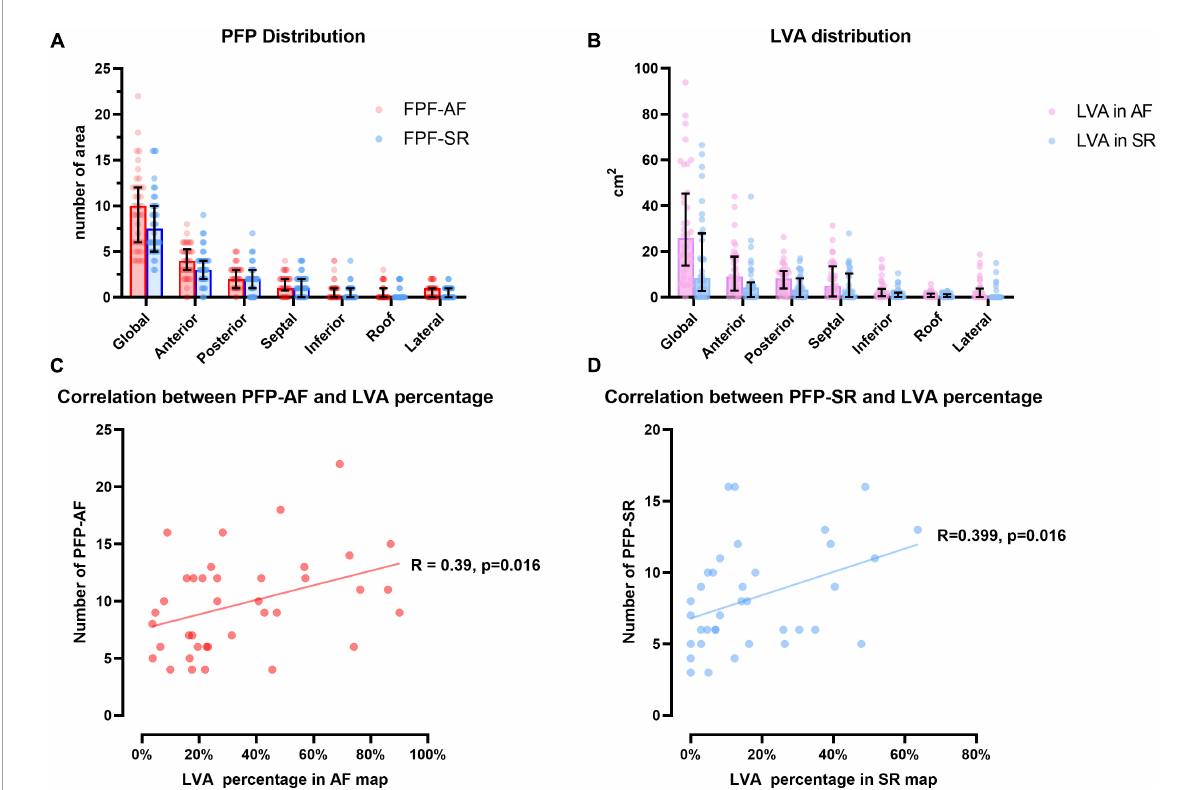
FIGURE3 Distribution of areas presenting prolonged fractionated potential and low voltage area. (A) Illustrates the number of areas presenting PFP-AF (red) and PFP-AF (blue) in global LA and each segment. (B) Illustrates the distribution LVA in LA at bipolar threshold of 0.5mV in AF (violet) and SR (light blue) maps. All values are expressed as median (upper margin of bar plot), 25th and 75th percentile (error bar in black). (C,D) Display the correlation between PFP and percentage of LVA during AF mapping (red) and SR mapping (blue), correlation coefficient and p value are annotated, respectively. PFP, prolonged fractionated potential; AF, atrial fibrillation; SR, sinus rhythm; LVA, low voltage area; LA, left